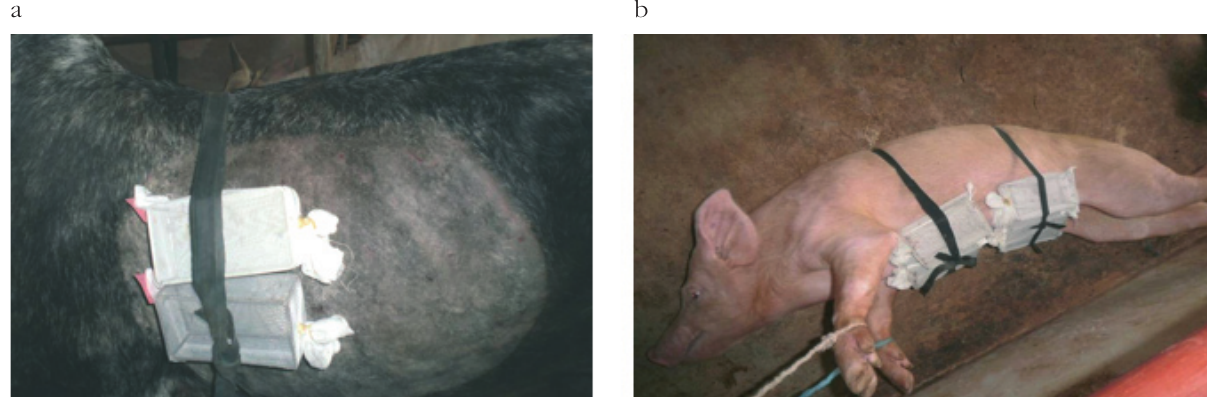
Fig. 1. – Tsetse flies from the CIRDES colonies fed on a cow (a) and on a pig